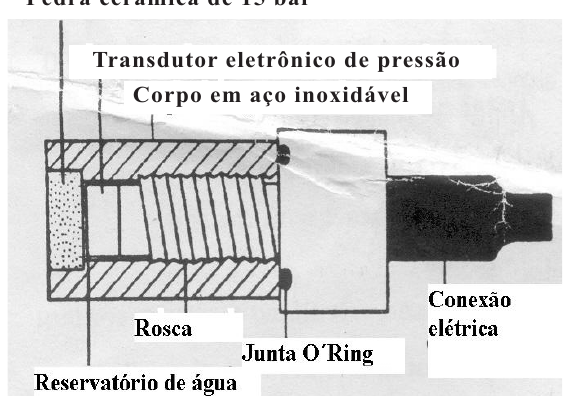
Figura 2. Tensiômetro desenvolvido por König et al. (1994).